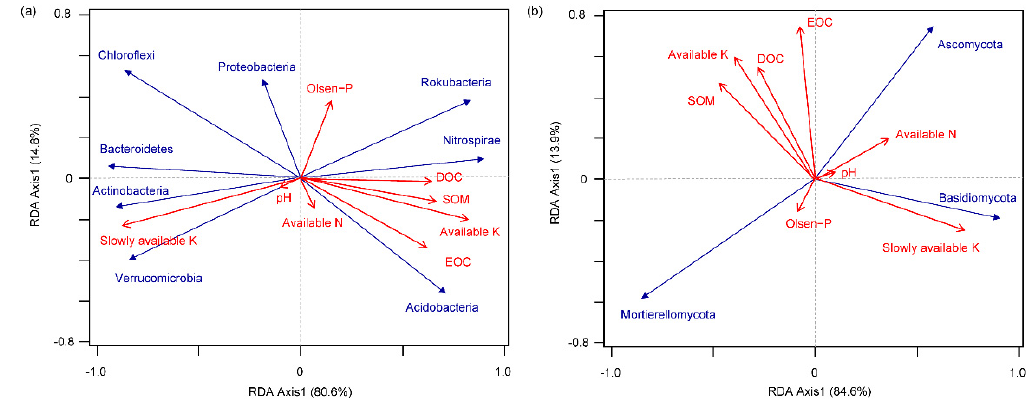
Figure 6. Redundancy analysis of soil properties and main ( a ) bacterial and ( b ) fungal communities at the phylum level in soils. Red lines represent soil properties; blue lines represent the bacterial and fungal phylum − level taxonomy.